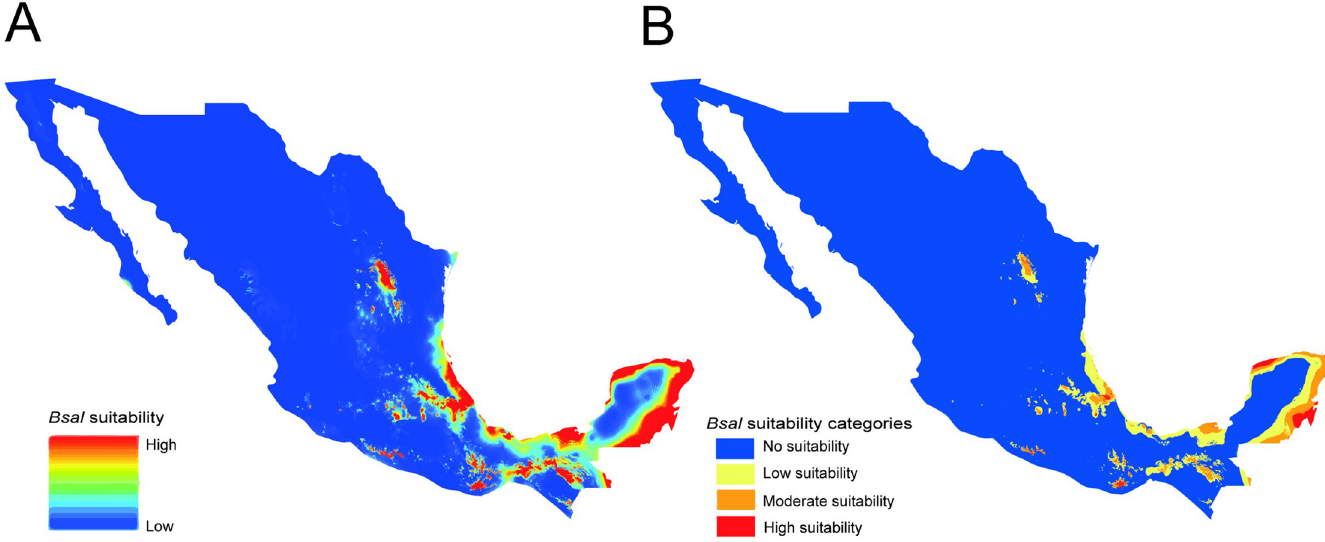
Fig 1. Suitability model for Bsal in Mexico. (A) Continuous model (B) Categorized model.